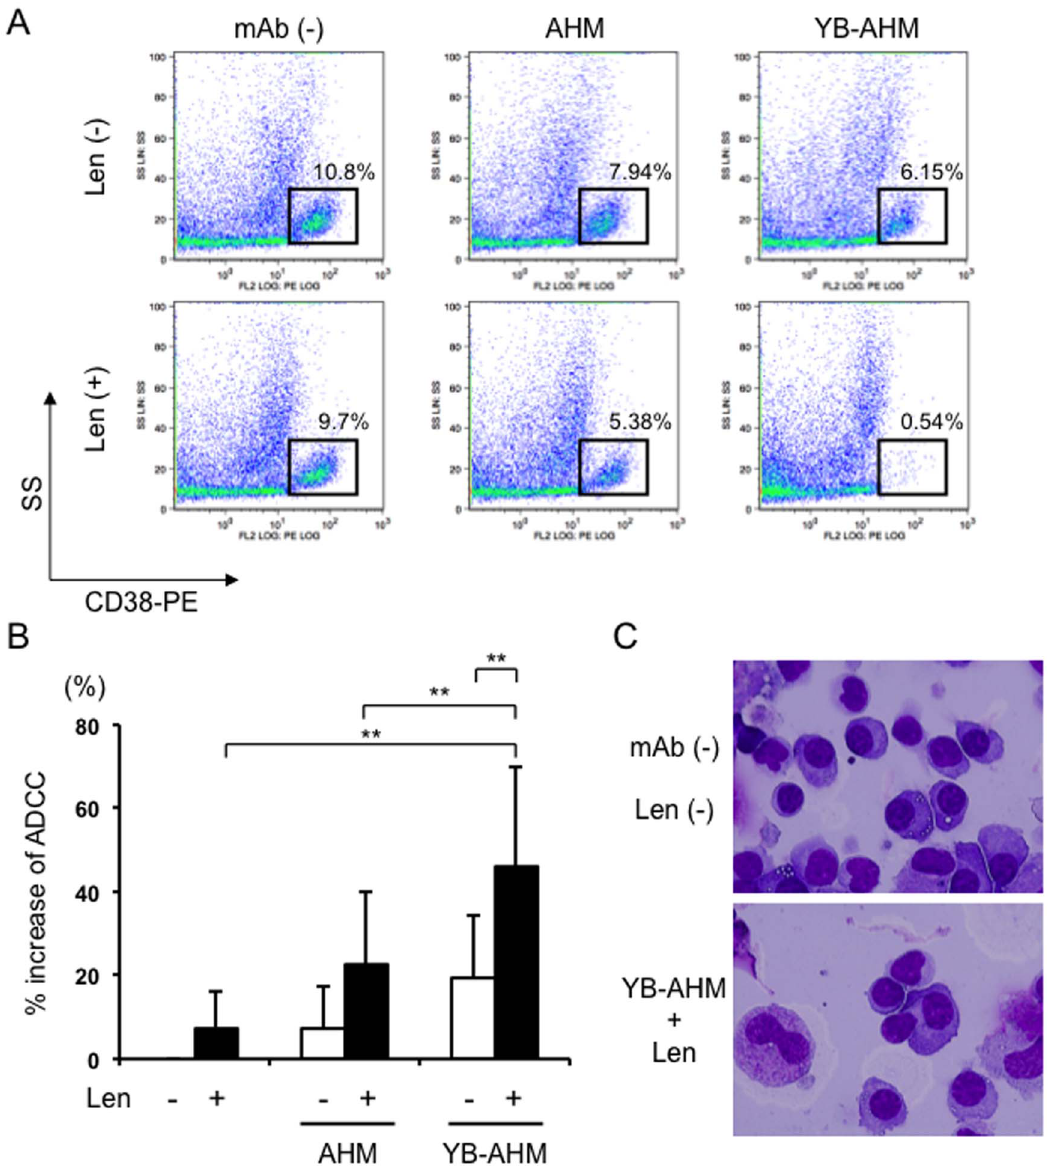
Figure 2. Combination of YB-AHM plus Len enhanced cytotoxicity against MM cells in BMMCs from MM patients. (A) BMMCs from a MM patient (no. 3) were pretreated with or without Len (3 m M) for 24 hours, and incubated in the presence of AHM or YB-AHM (0.1 m g/mL) for 24 hours. Thereafter, the cells were stained with control PE-labeled mouse IgG or PE-labeled CD38 mAb, and analyzed by flow cytometry. MM cell populations were indicated within squares according to side scatter (SS) and CD38 expression profiles. (B) Cytotoxic activity was estimated by % increase of dead cells from the baseline of CD38 ++ MM cell fractions in BMMCs from MM patients (n=10). Data presented are mean 6 SD (**, p , 0.01). (C) BMMCs from a MM patient (no. 5) were treated with or without Len (3 m M) and YB-AHM (0.1 m g/mL) as above. Cytospun preparations were stained with a Wright-Giemsa solution, and examined under a microscope (original magnification, x 1000).